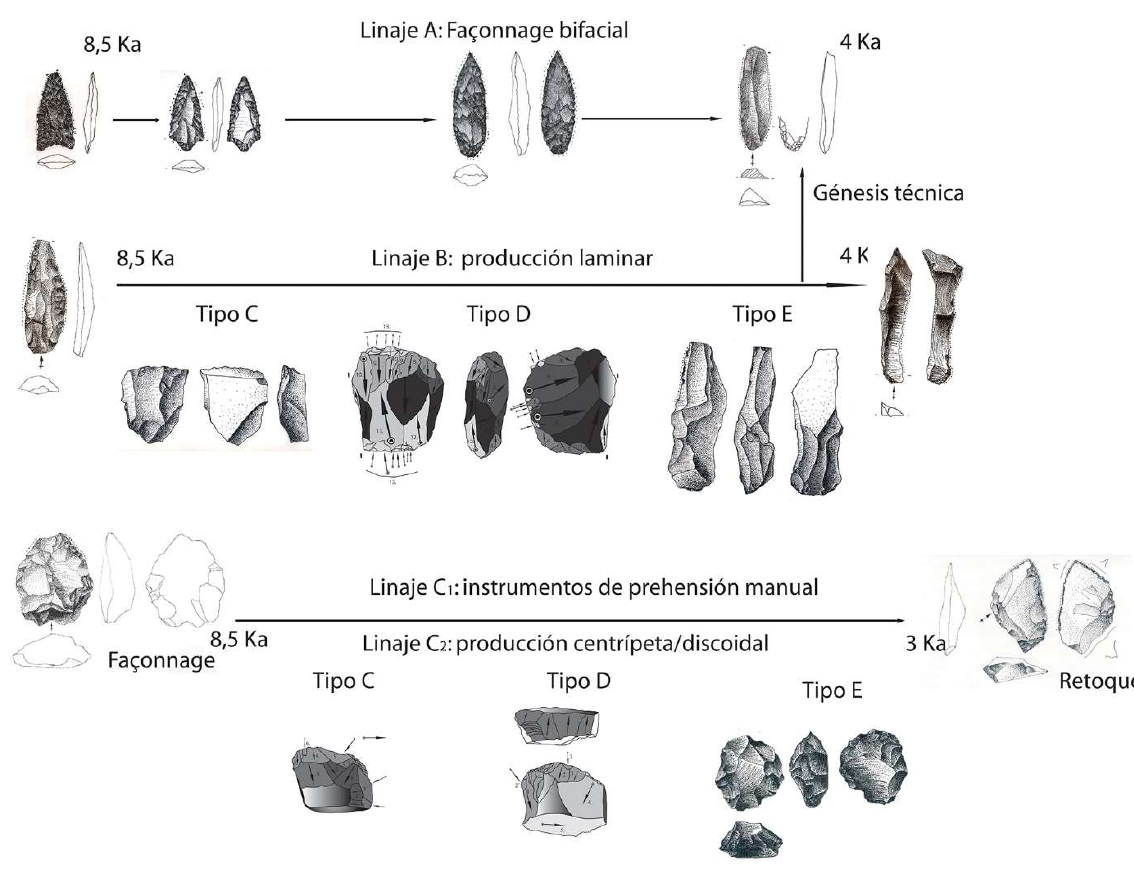
Figura 19. Ejemplos de linajes técnicos en América del